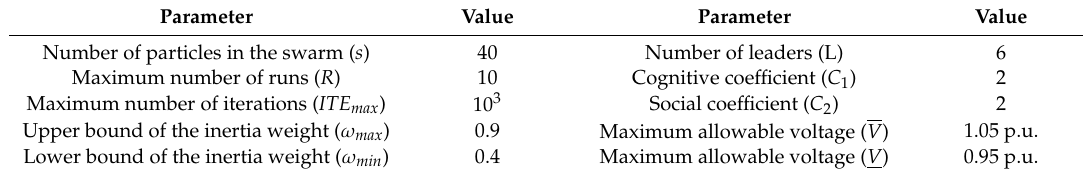
Table 2. Parameters of the MLPSO algorithm for the optimal placement and sizing.